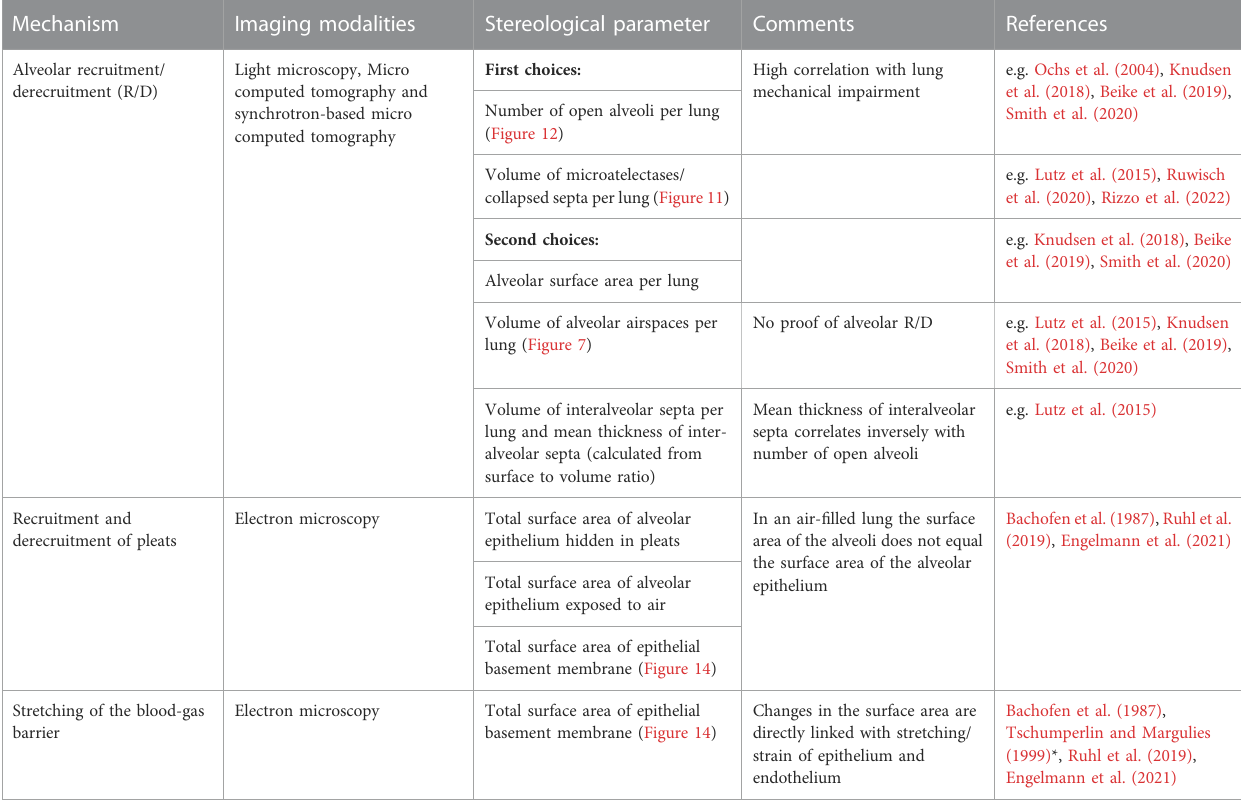
TABLE 1Design-based stereological parameters to study the micromechanics of interalveolar septa. Note, a forth mechanism is shape change due to mechanisms other than stretching/de-stretching or recruitment/de-recruitment (e.g. Reimelt et al., 2023). An example is the straightening of the curvy run of the blood-gas barrierwhichcanoccurindependentlyfromstretchingorrecruitmentoftheblood-gasbarrier.Asaresult,thealveolarvolumeincreasesbutthesurfaceareaofthe air-exposed alveolar epithelium remains stable. * Did not determine surface area using stereological